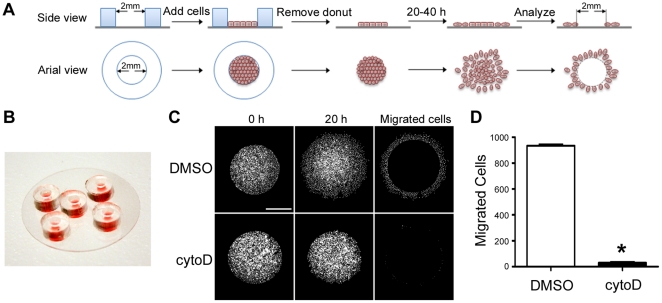
A modified radial migration assay – the Donut assay.(A) A schematic representation of the donut migration assay in which cells are seeded at confluence on an extracellular matrix-coated glass coverslip within a donut-shaped silicone gasket. After the cells have stably adhered, the gasket is removed, allowing the cells to migrate radially. Images of the monolayer are captured immediately after donut removal and at any time point thereafter that is suitable to allow migration of a given cell line. A custom ImageJ macro uses the initial image as a subtractive mask to determine the number of migrated cells in the final image taken at the end of the assay. Details are given in Materials and Methods. (B) A picture of five donut gaskets on a single 25 mm coverslip; this allows facile setup of replicate assays to increase throughput and generate statistically significant data. (C) COS-7 cells were subject to the donut migration assay in the presence of 2 µM cytochalasin D (cytoD) or DMSO as a vehicle control. Representative images taken at the beginning (0 h) and end (20 h) of the assay, as well as masked (final minus initial) images depicting migrated cells are shown. (D) The number of migrated COS-7 cells was calculated using the ImageJ macro as described in Materials and Methods. Data represent the mean ± S.E. of five donuts per coverslip with three separate coverslips per treatment. (* = P<0.001).